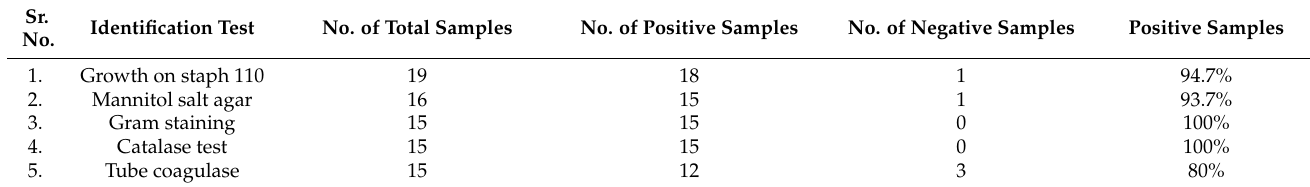
Table 1. Microbiological identification test results of mastitic buffalo S. aureus isolates.